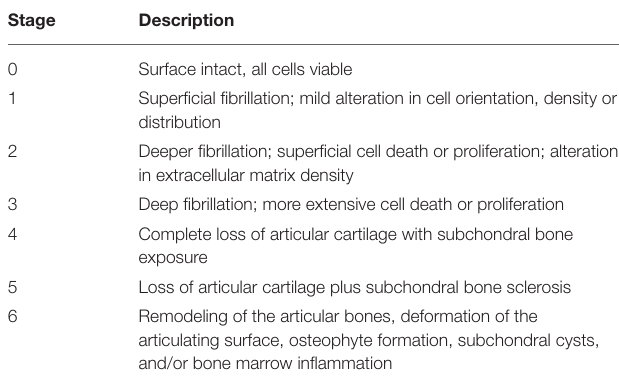
TABLE 1 | CBCT Grading system for severity of DTMJ of the temporomandibular joint (17). Grades